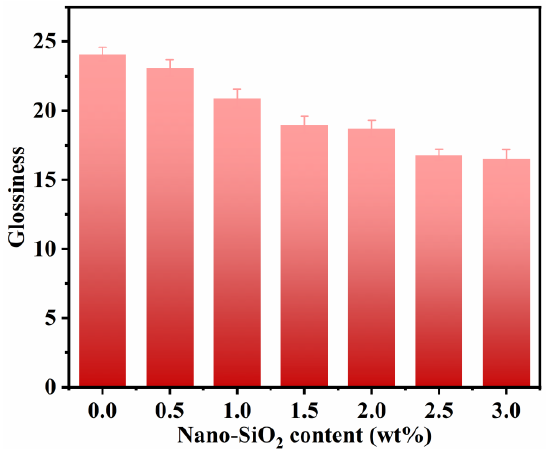
Figure 3. Effect of nano-SiO 2 content on the glossiness of WAA paint film.